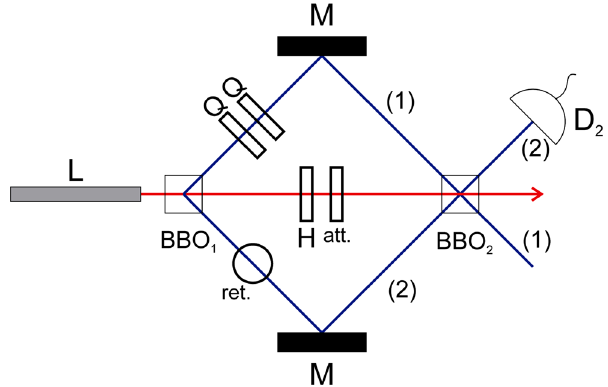
Figure 1. A coherent laser (red line) pumps two type-1 beta-barium-borate crystals ( BBO ), which, with probability amplitude g , emit pairs of single photons with polarization V in the specified paths (blue lines), via spontaneous parametric down-conversion (SPDC). The paths of the photons emitted by BBO 1 are aligned with mirrors so that they match with the paths that BBO 2 emissions (with the same frequency) would follow. Q and H are quarter and half waveplates, respectively. ret . is a retarder, att . is an intensity attenuator, M are mirrors, and D 2 is a detector in path (2). Detections after BBO 2 show interference between probability amplitudes of pairs of photons emitted in BBO 1 and BBO 2 . Consequently, this is not interference between paths (1) and